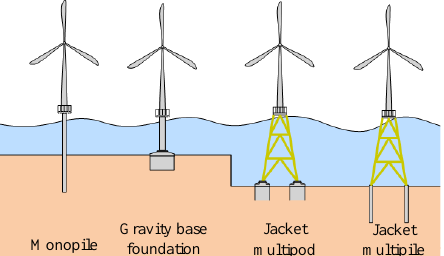
Figure 1. Typical foundations for a wind turbine structure.